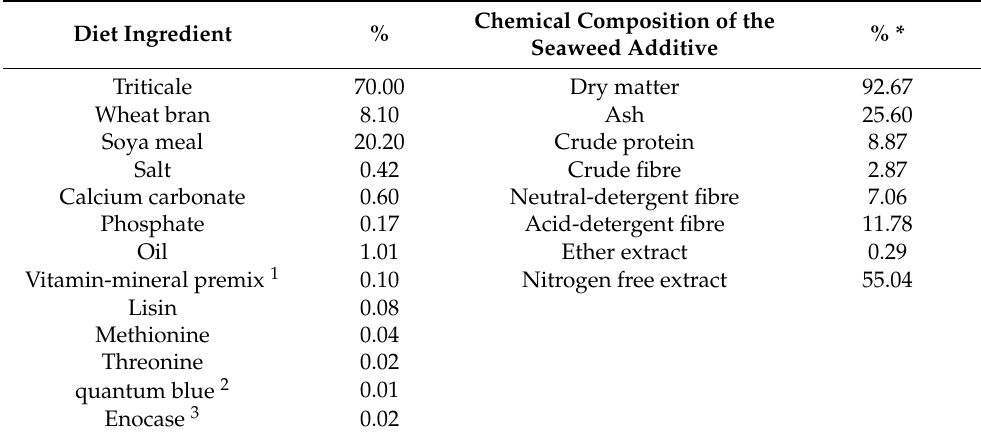
Table 1. Composition of the regular diet and chemical composition of the seaweed additive (SWA). Chemical Composition of Diet Ingredient %